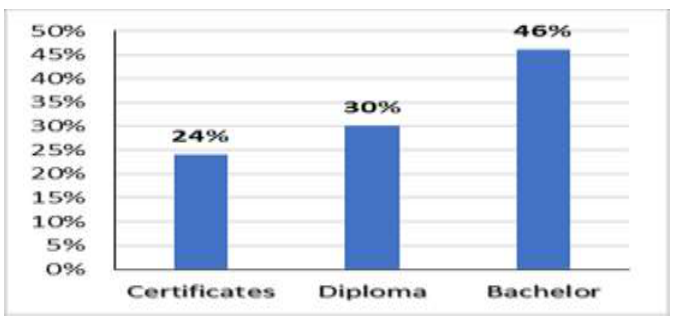
Figure 3. Education Level of